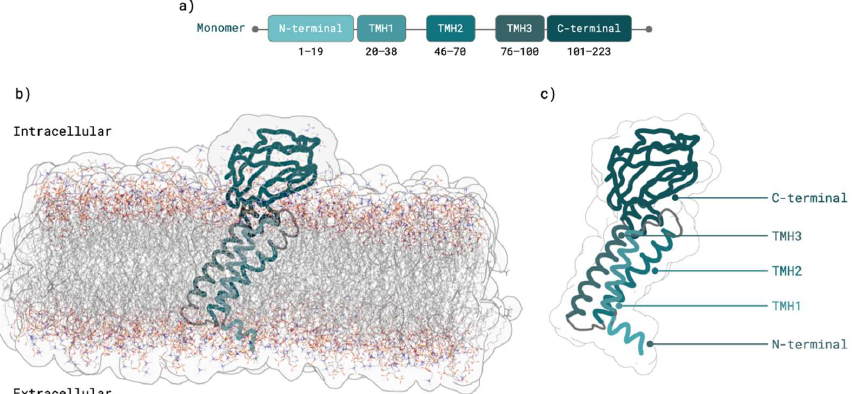
Figure 2. SARS-CoV-2 M protein monomer. ( a ) M protein domains predicted by TMHMM [34,35] membrane predictor. ( b ) TMHMM [34,35] M protein monomer structure prediction after equilibration in membrane with ER membrane composition. ( c ) M protein structure with domains